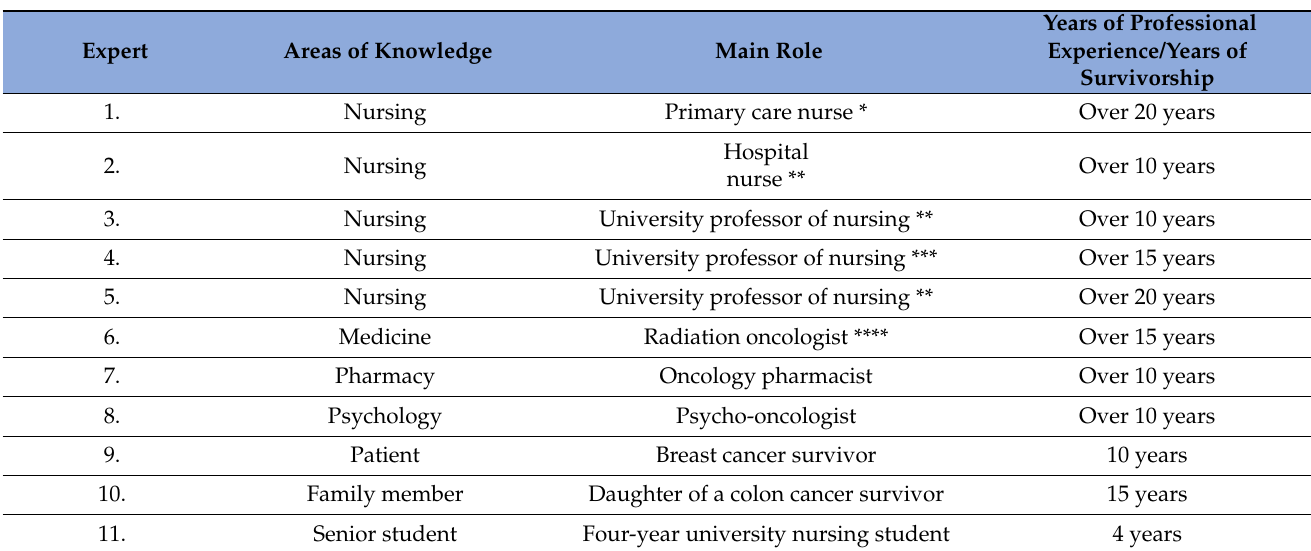
Table 2. Expert Panel Members.